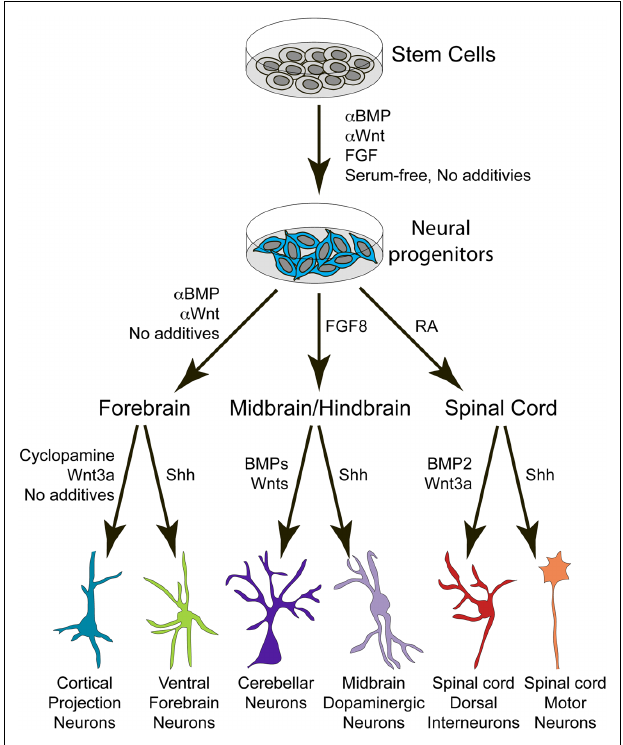
FIGURE 3 | Schematic depicts the general procedure for deriving different neuronal subtypes from PSCs by utilizing secreted patterning factors identified in the developing embryo. BMP, bone morphogenetic protein; FGF, fibroblast growth factor; RA, retinoic acid; Shh, Sonic